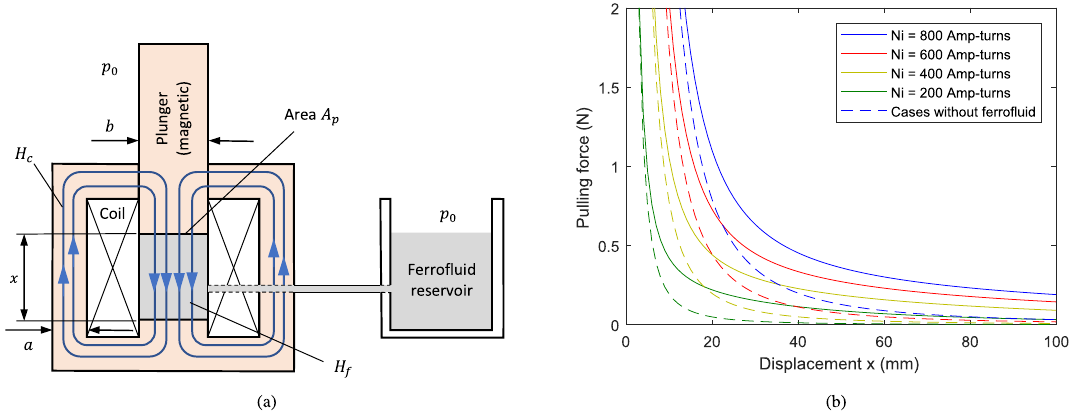
Figure 7. Example actuator system with axial-field mode operation (Case 1): ( a ) schematic; ( b ) force